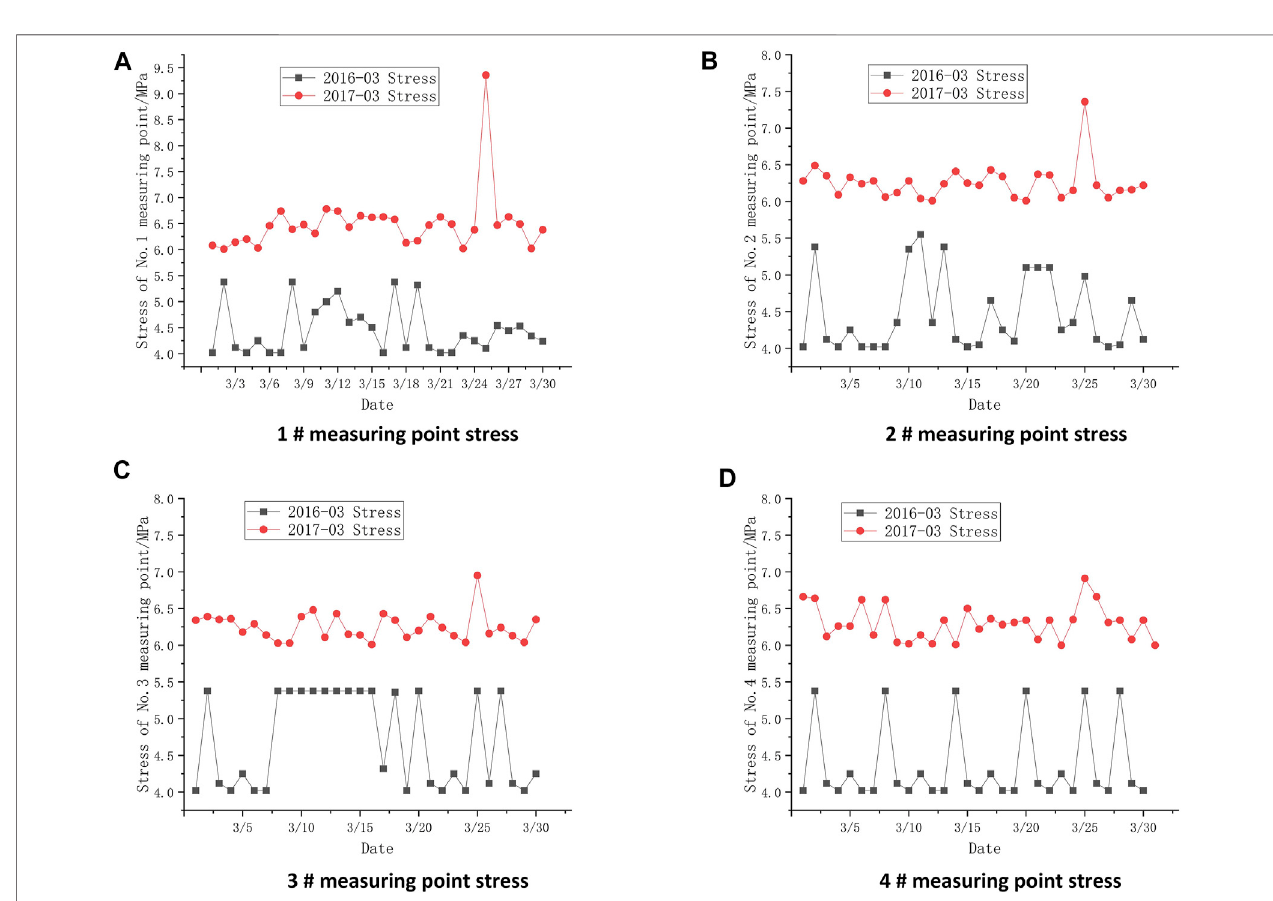
FIGURE8| Stresscurvediagramsforeachmainroadway. (A) 1#measuringpointstress, (B) 2#measuringpointstress, (C) 3#measuringpointstress,and (D) 4 # measuring point stress